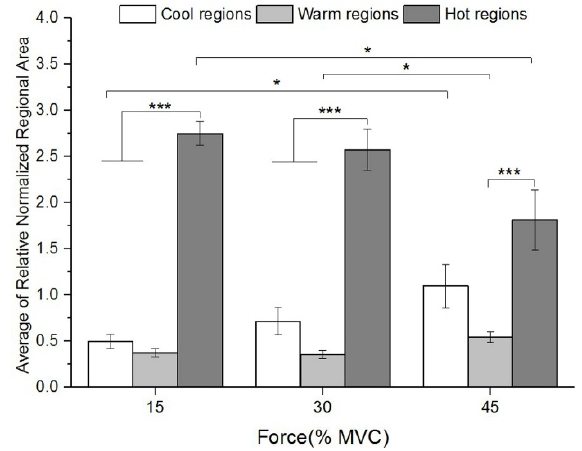
Figure 7. The average of relative normalized regional area of 8 STMs at three force levels. Asterisks indicate significant difference in multiple compares (* 0.01 < p < 0.05; *** p < 0.005).